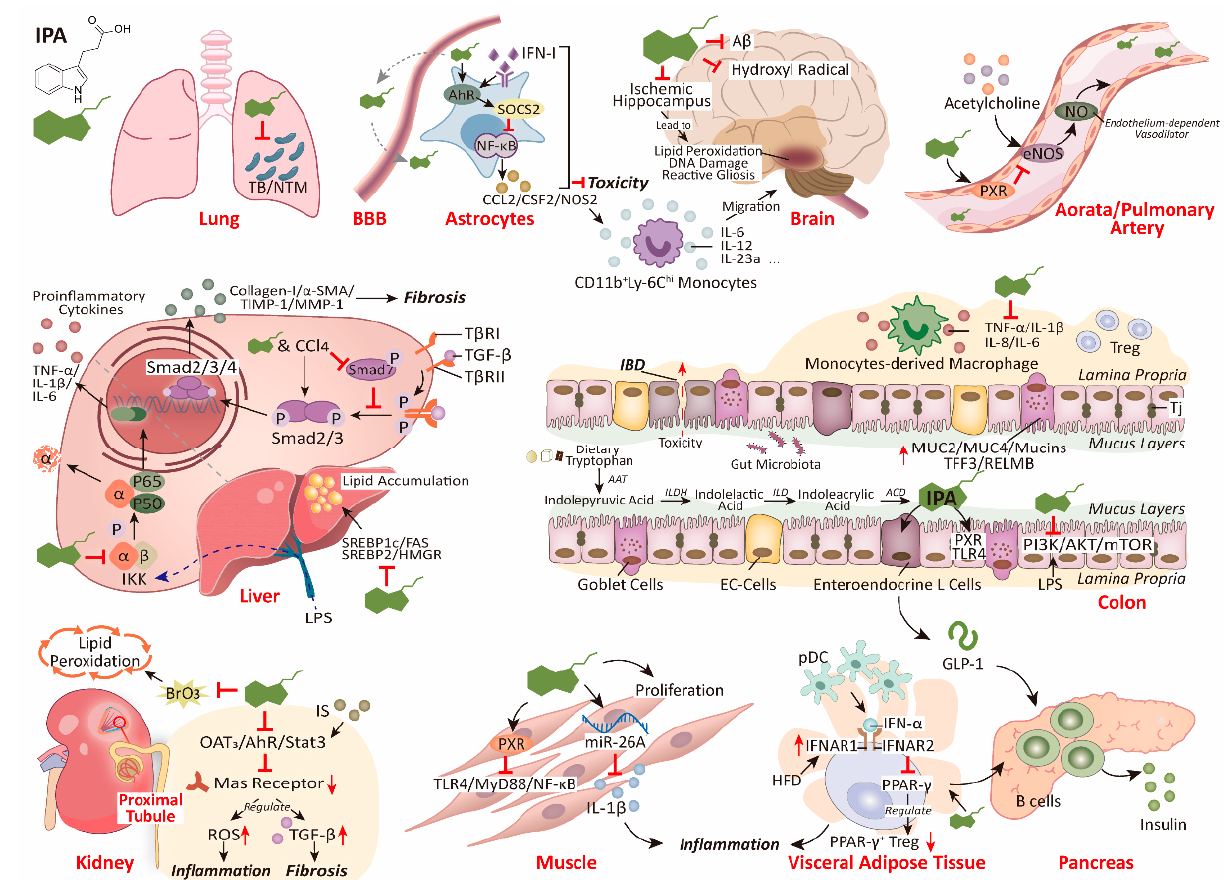
Figure 2. Biological functions of IPA through various gut–organ axes. Blood circulation enables IPA to act on various target organs, regulating host disease and health through biological mechanisms as shown. A β : Amyloid β -protein, BBB: Blood–brain barrier, eNOS: endothelial nitric oxide synthase, GLP-1: Glucagon-like peptide-1, HFD: High-fat diet, IBD: Inflammatory bowel disease, IFN-I: Type I interferons, IS: Indoxyl sulfate, LPS: Lipopolysaccharide, NTM: Non- Mycobacterium tuberculosis , PXR: Pregnane X receptor, ROS: Reactive oxygen species, TJ: Tight junction, TB: Tu- berculosis.